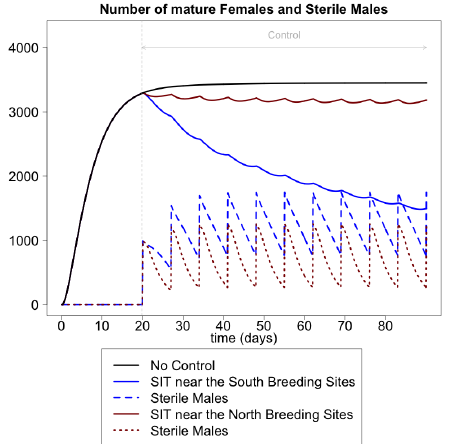
Fig. 7. Evolution of the density of mature females with Northern wind with two spatial strategies of SIT ( 1000 sterile males released per week) from the 20th